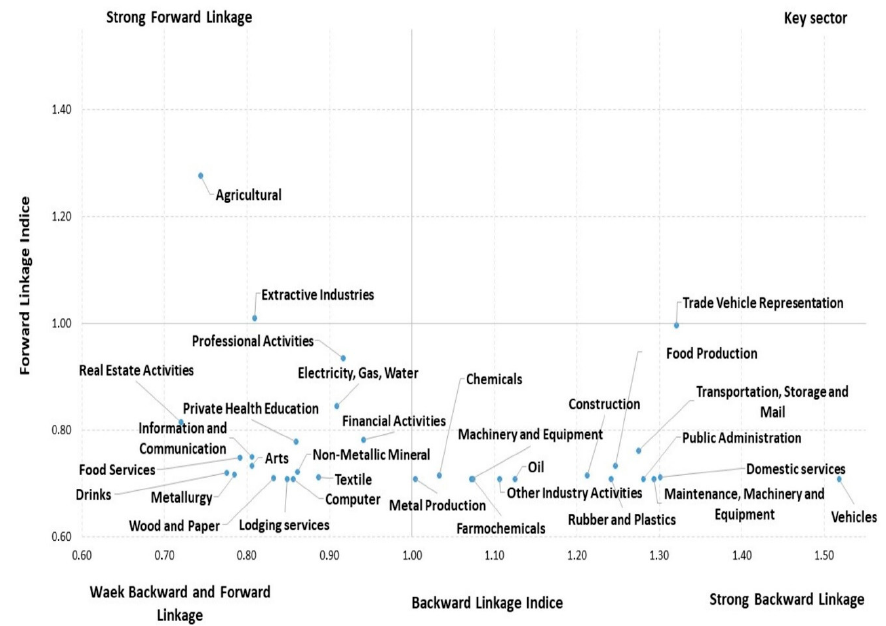
Figure 4. Rasmussen and Hirschman linkages indices (direct, indirect, and induced effects) of water flows in forward and backward linkages in Ceará.